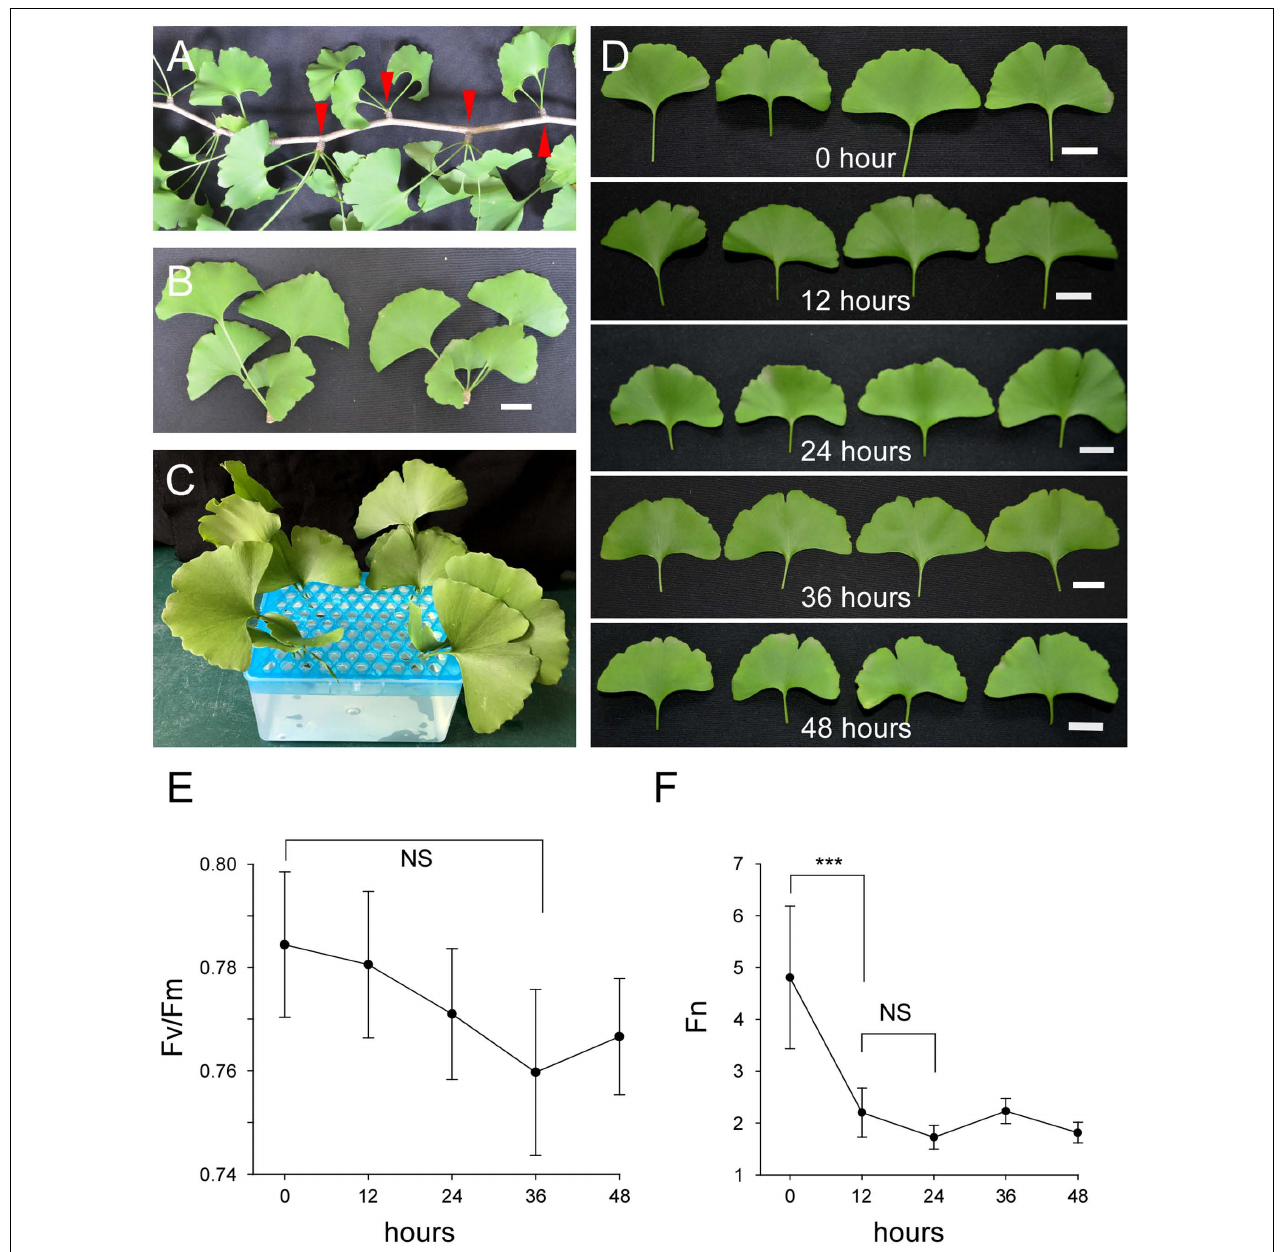
FIGURE 1 | Cultured post-harvest Ginkgo leaves are able to maintain vitality for a long period of time. (A) A branch of Ginkgo tree with several short shoots indicated by red arrow heads. (B) Separated short shoots of Ginkgo trees. Bar = 2 cm. (C) Cultured Ginkgo leaves in MS solution. (D) Phenotypes of Ginkgo leaves after different periods of culture in solution. No significant changes are observed within 48 h. Bars = 2 cm. (E) F v/ F m values of Ginkgo leaves after different periods of culture in solution. (F) F n values of Ginkgo leaves after different periods of culture in solution. Data for independent experiments are shown (mean ± SD; n = 10;